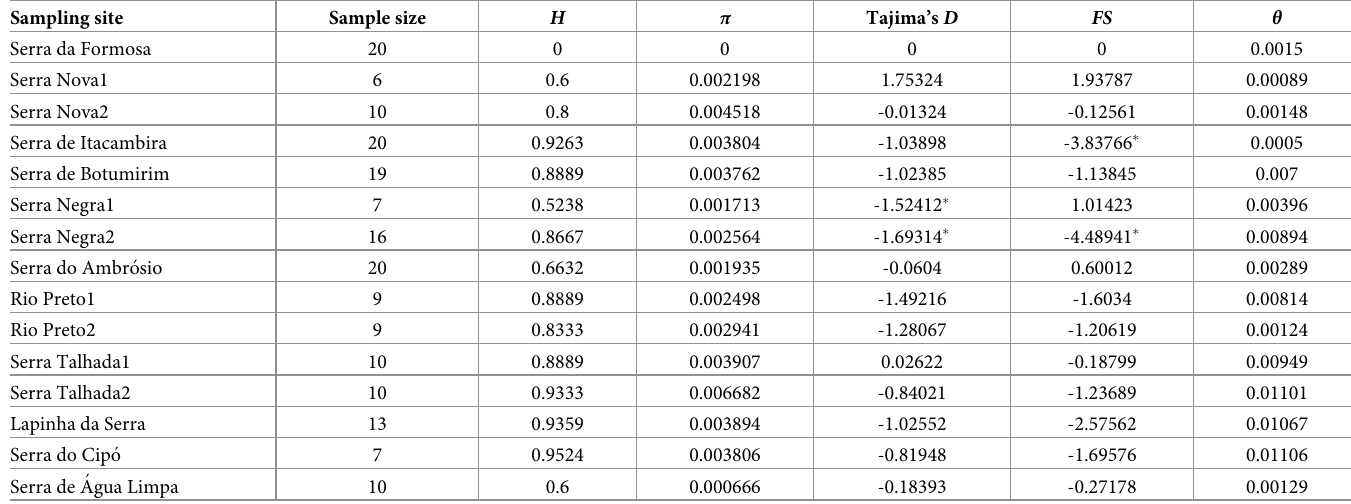
Table 1. Sample size, estimates of haplotype ( H ) and nucleotide diversity ( π ), Tajima’s D and Fu’s Fs results for the sample sites with six or more individuals. Sampling site